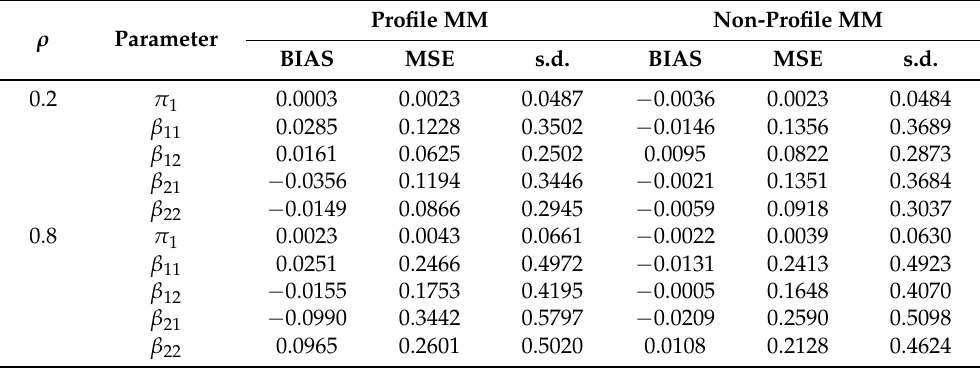
Table 6. Parameter estimation results in Scenario